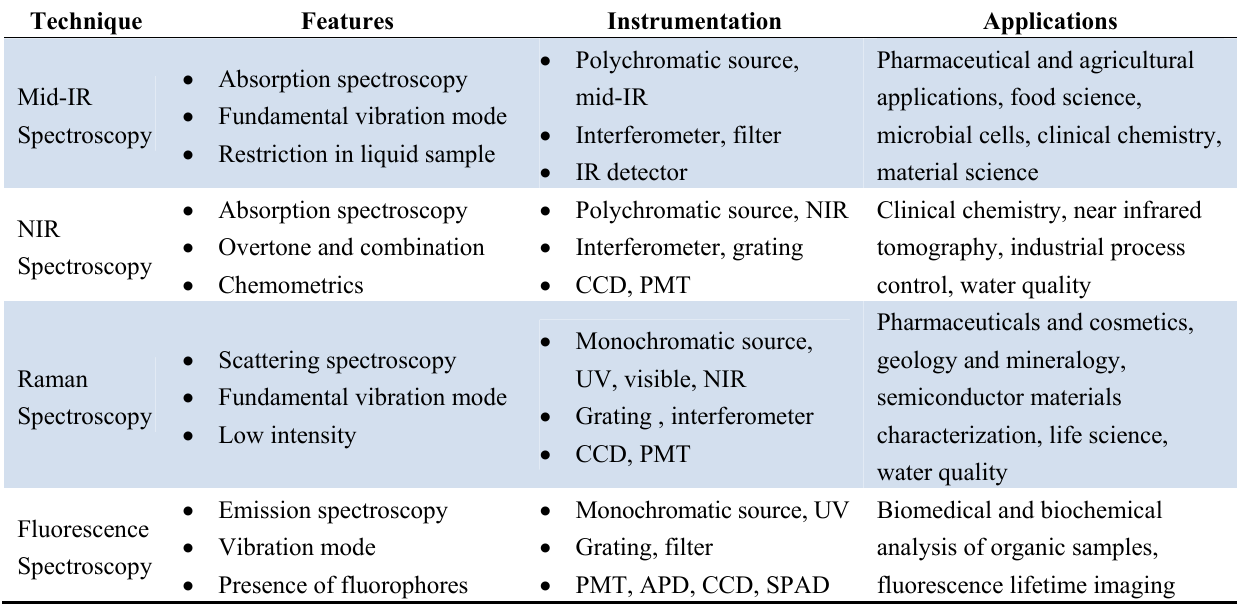
Table 2. Comparison of different optical